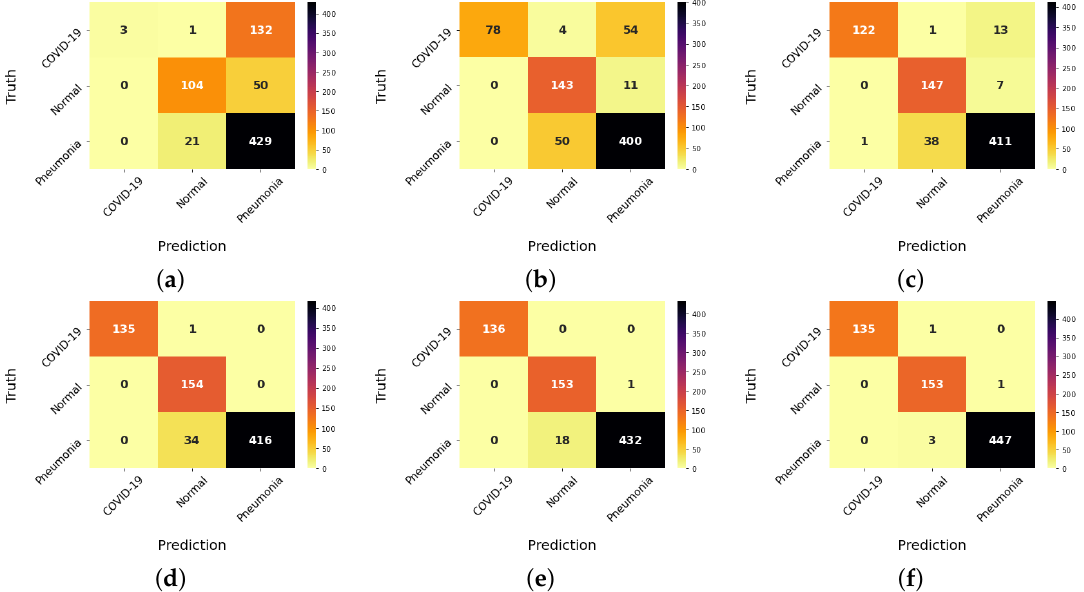
Figure 5. Confusion matrices of the proposed model with different optimizers using the LeakyReLU activation function set at ( α = 0.1). ( a ) AdaGrad, ( b ) AdaDelta, ( c ) SGD, ( d ) Adam, ( e ) AdaMax, and ( f )